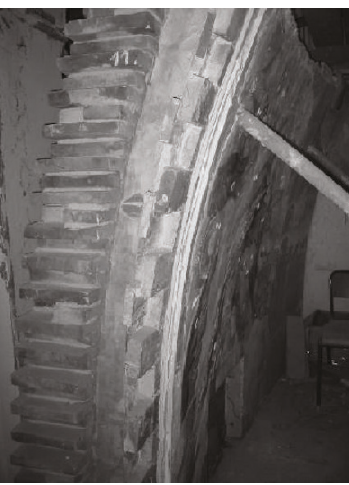
Figure 4: Picture of the 1 : 1 dome scale